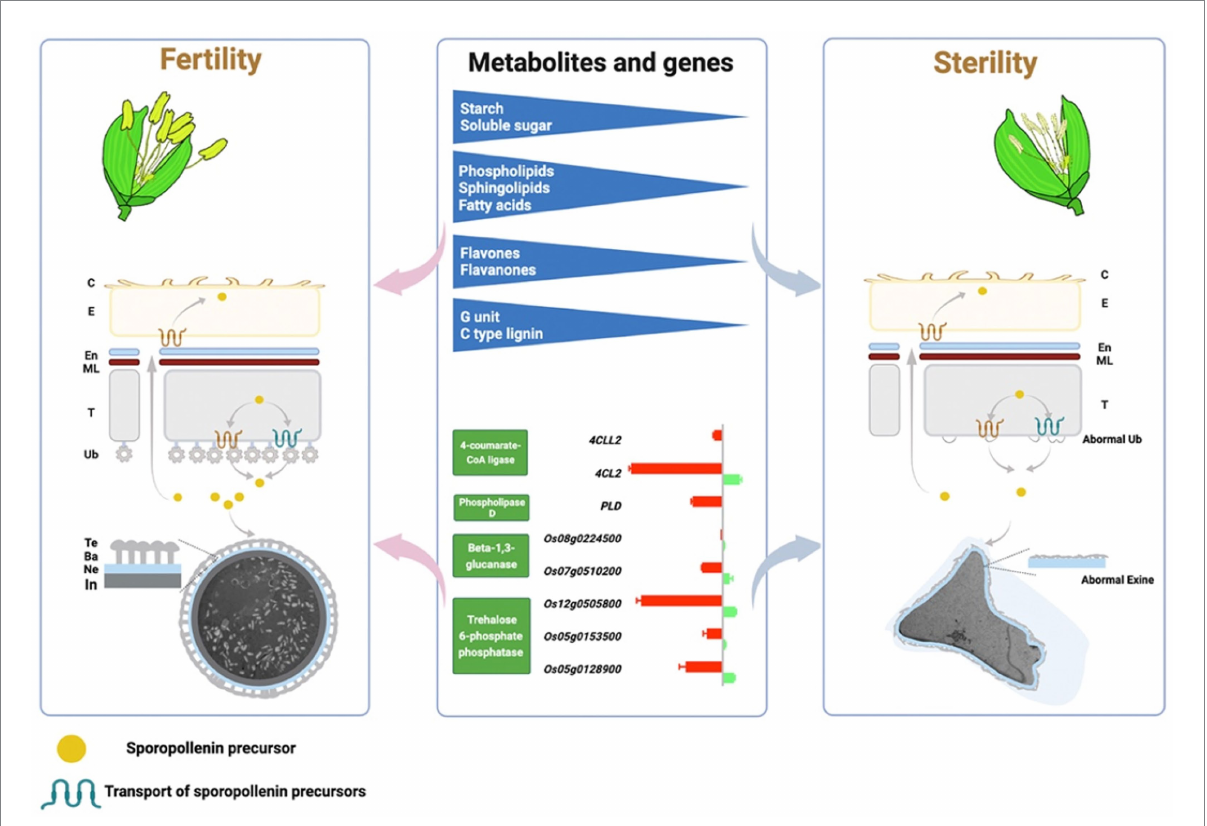
FIGURE 8 A model graph of the metabolites and related genes in the metabolic pathways of sugar, lipid and phenylpropanoid involved in pollen wall and male fertility formation. C, Anther cuticle; E, Epidermis; En, Endothecium; ML, Middle layer; T, Tapetum; Ub, Ubisch body; Te, Texine; Ba, Bacula; Ne, Nexine; In,